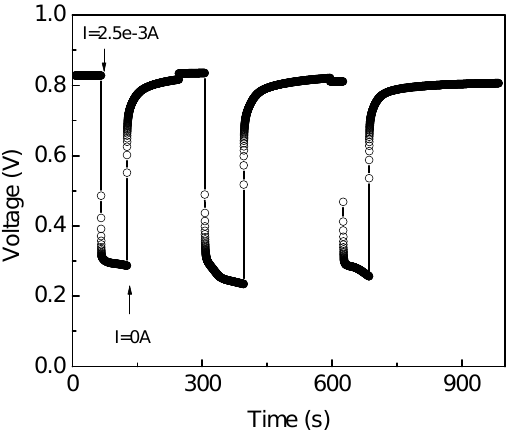
Figure 8. PMFC behavior under charge and